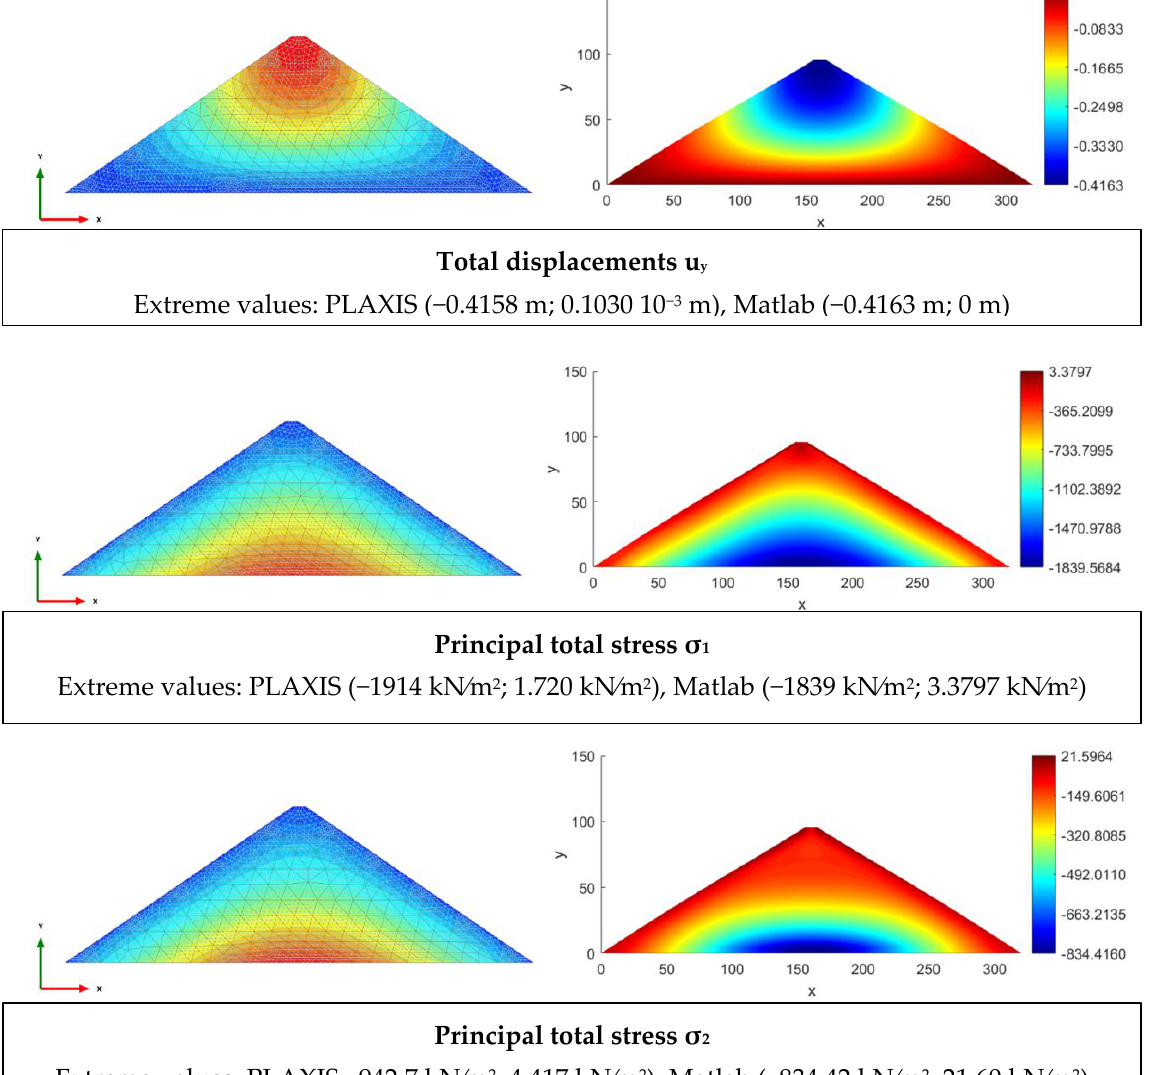
Figure 9. Comparisons of horizontal (u x ) and vertical (u y ) displacements and normal stresses calculated for 𝜔 = 10 −6 and 𝑡𝑜𝑙 = 10 −10 .